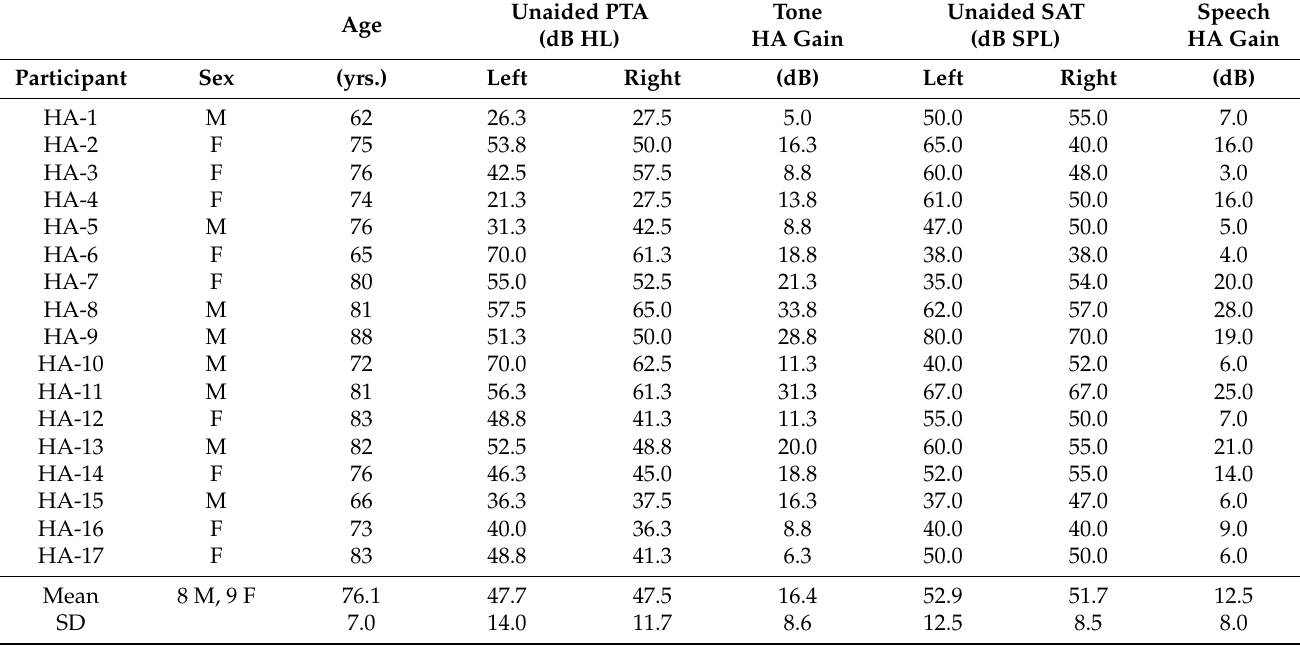
Table 1. Demographic information for the HA